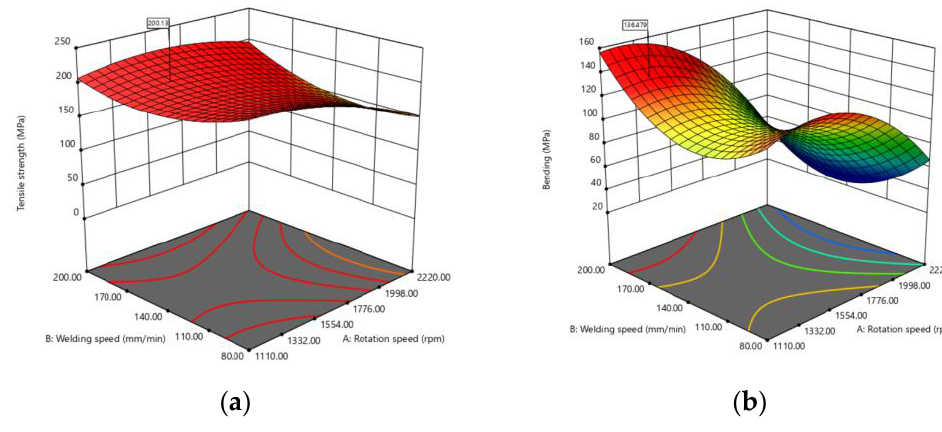
Figure 3. ( a ) Predicted conditions of UTS, ( b ) predicted conditions of MBS.